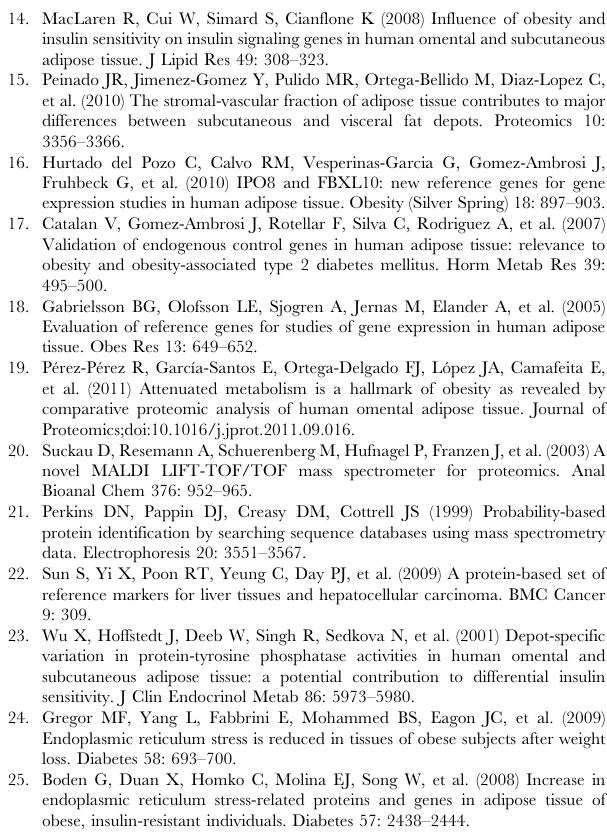
Table S1 Clinical characteristics of the individuals included in this study.